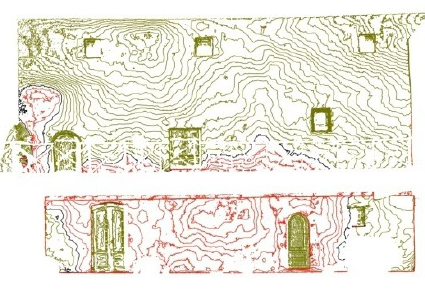
Figure 7: North-East